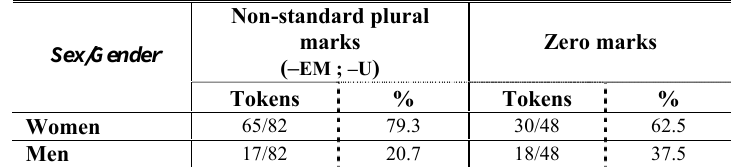
Table X: Non-standard and absence of third person plural verbal marking and Sex/Gender – Funchal (EP)